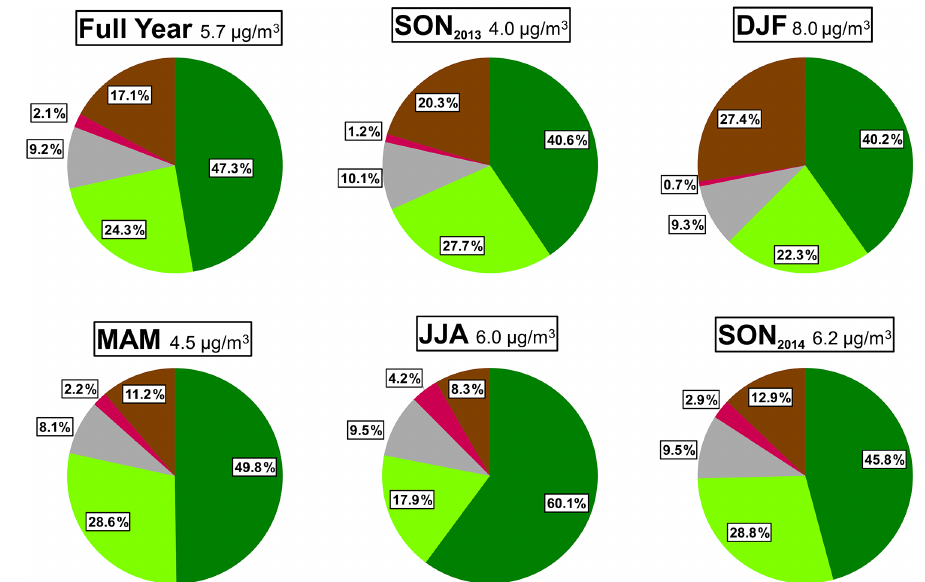
Figure 4. OA pie charts for the whole year and for the different